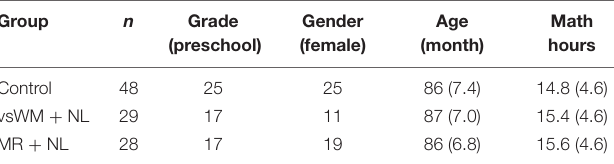
Standard deviations are shown in brackets. Math hours refer to the amount of mathematical training in school between the pre and post-training. vsWM = visual-spatial working memory; NL = number line; MR = mental